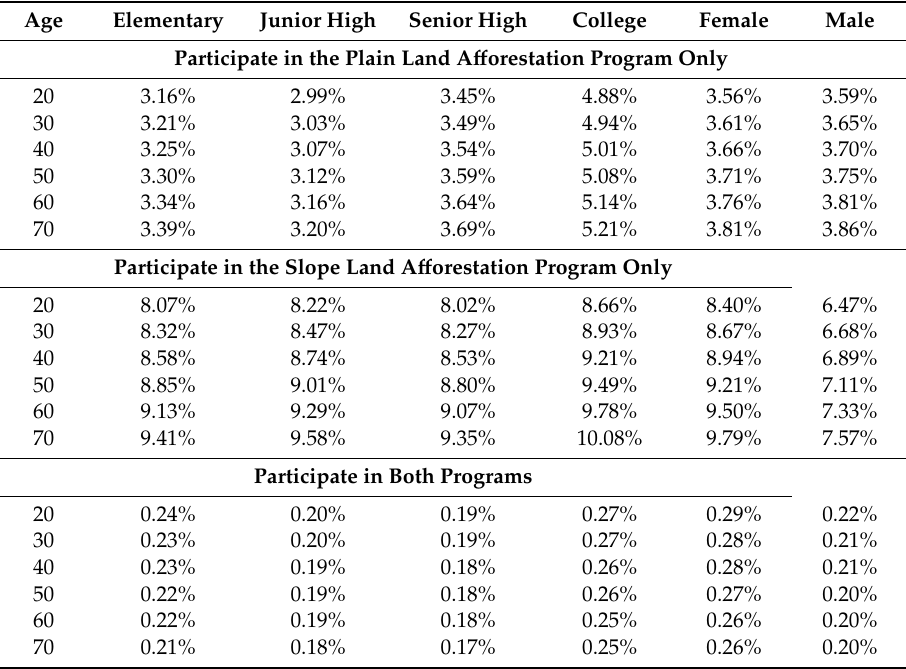
Table 4. Simulation results of participation in a ff orestation